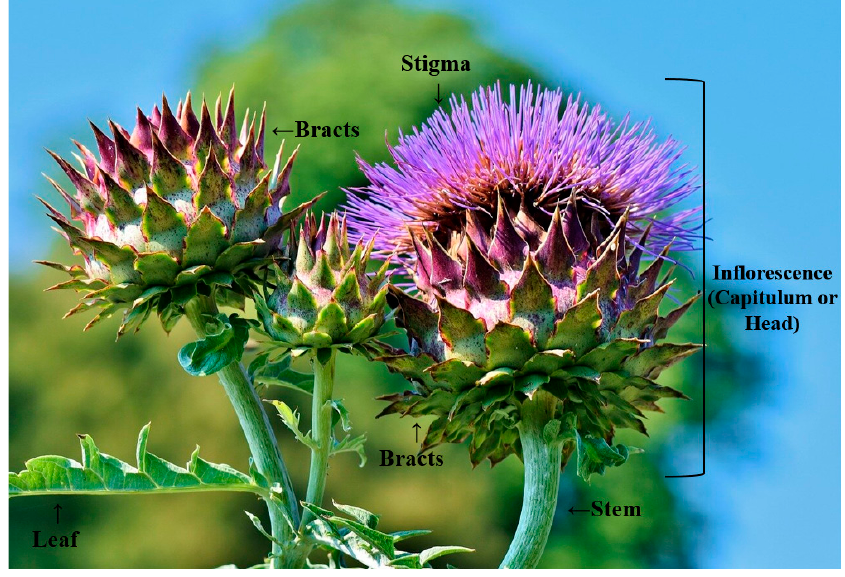
Figure 1. Cardoon flower [34].